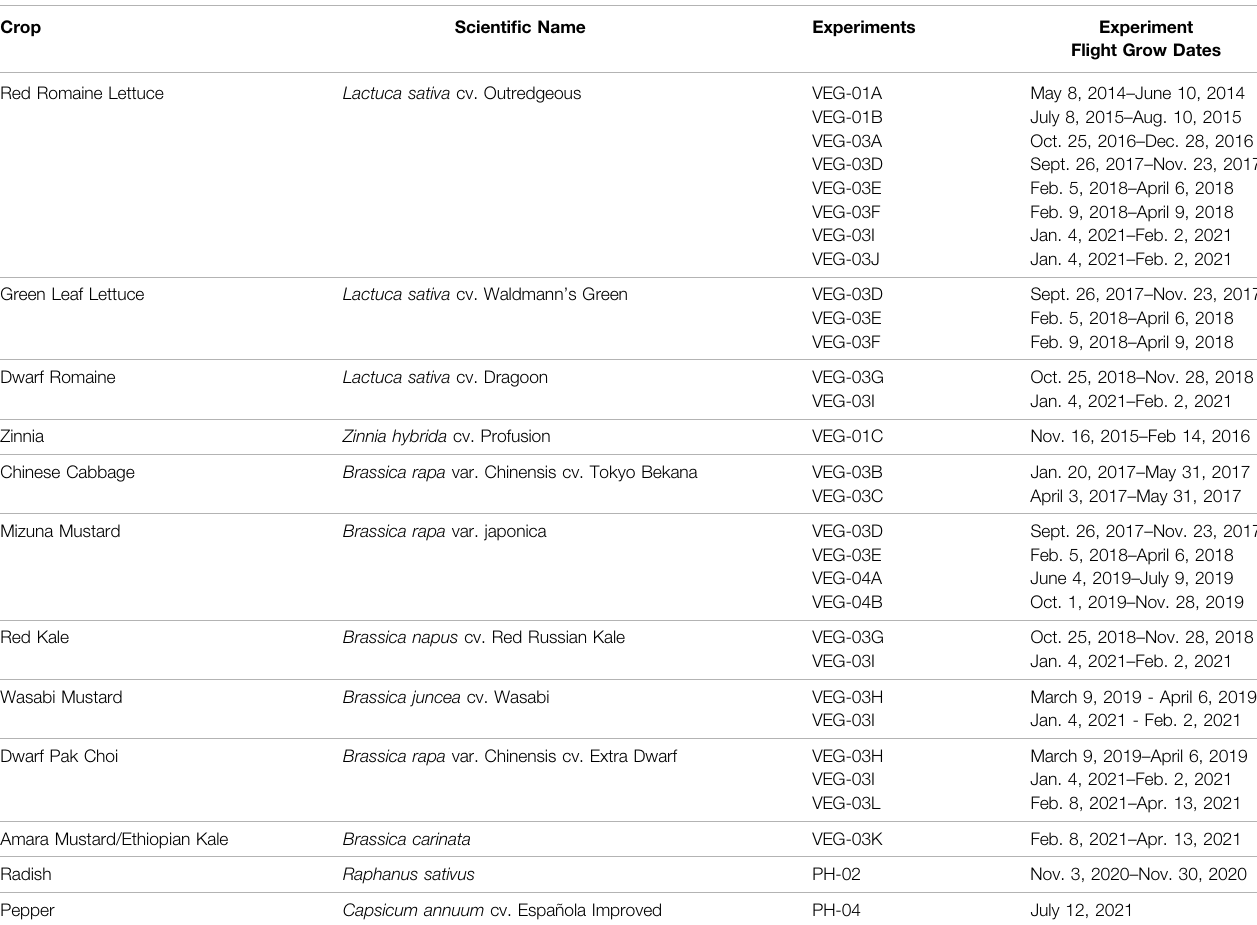
TABLE 1 | NASA crops grown in space fl ight in Veggie and